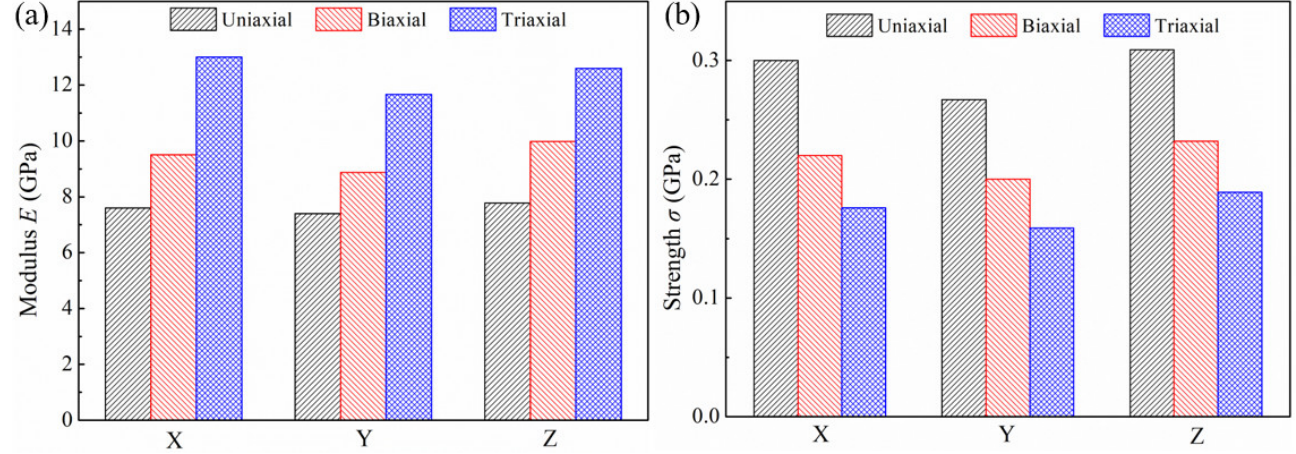
Figure 3. ( a ) Young’s modulus, and ( b ) ultimate strength of NPG under different loading conditions.